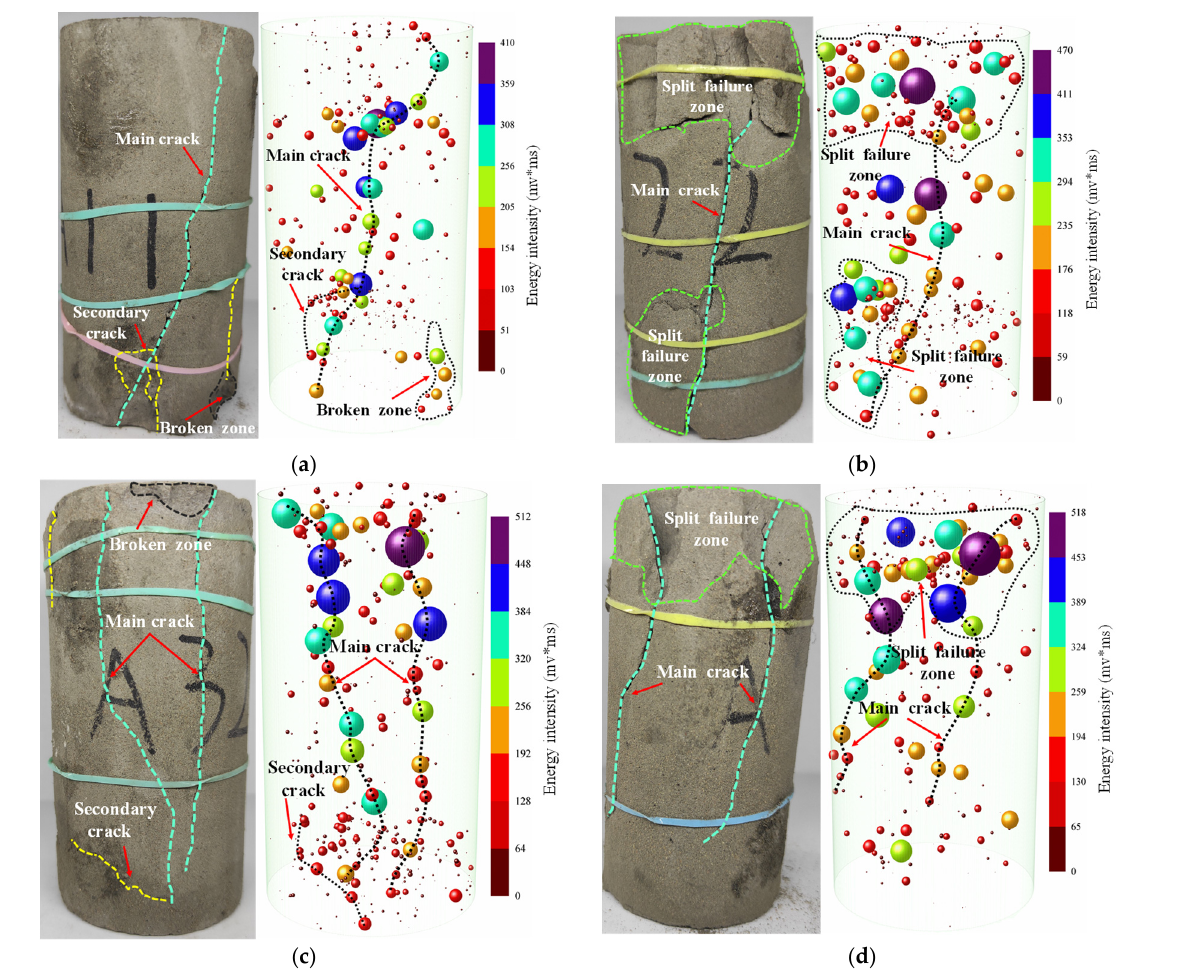
Figure 6. Failure mode and AE event points of ASPM specimens under different loading rates. ( a ) 0.002; ( b ) 0.005; ( c ) 0.0075; ( d ) 0.01.